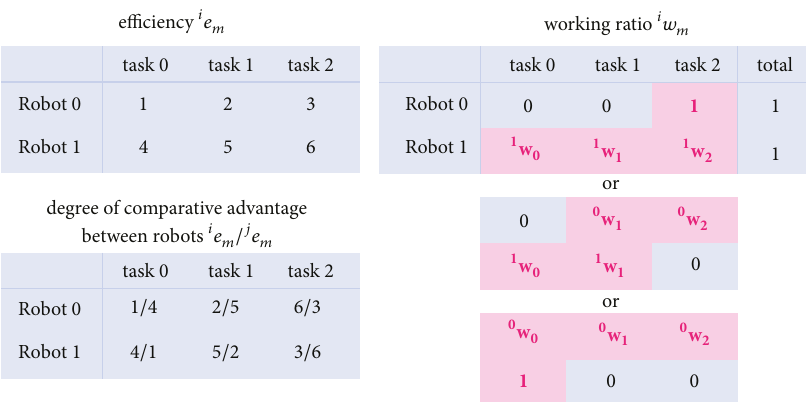
Figure 4: Comparative advantage with multiple tasks and two